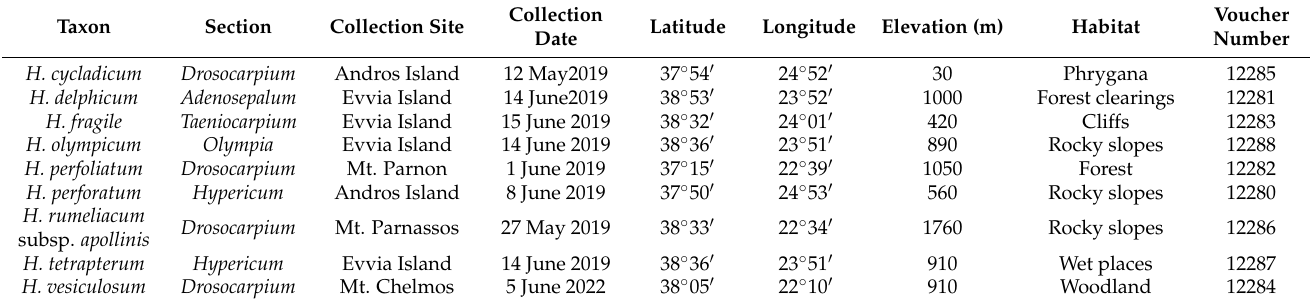
Table 1. Collection data of the Hypericum species